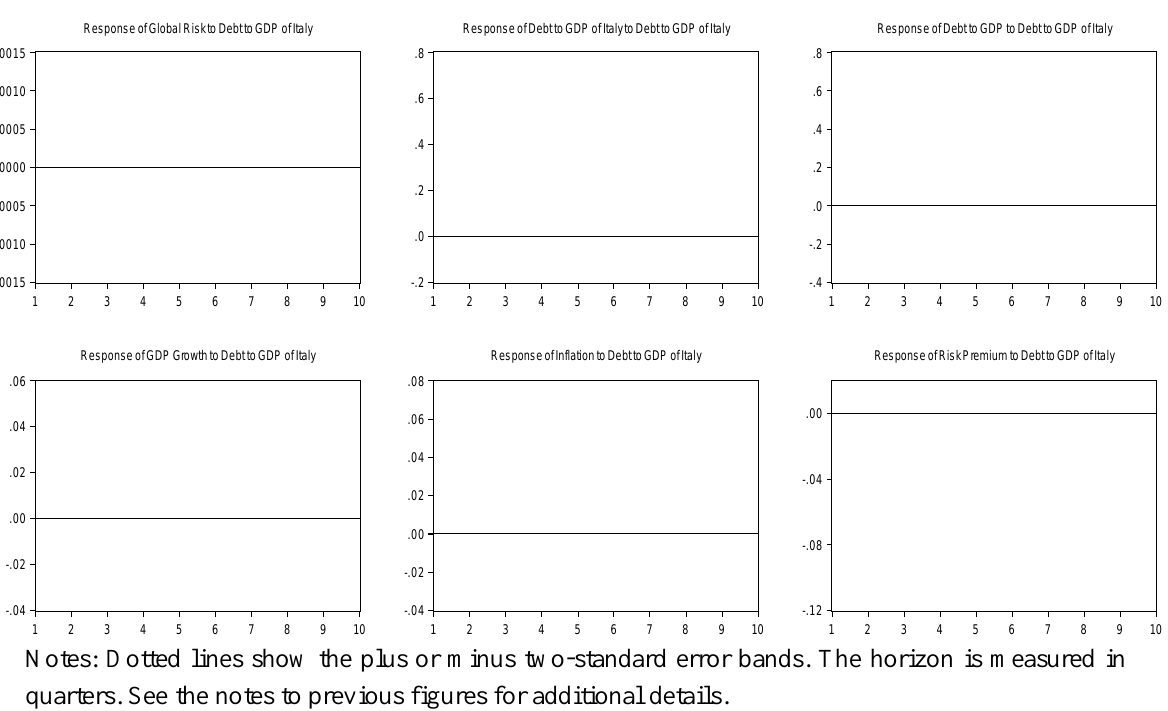
Figure 14. Pre-crisis response of EMU countries to a shock to the Italian debt-to-GDP ratio: 2001–2007.